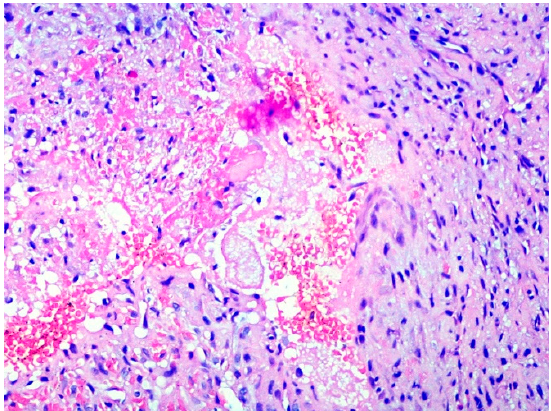
Figure 3. Fibrous connective stroma containing abundant vascular tissue; vascular lacunae appeared filled by fragmented and coagulated red blood cells, sometimes with a ghost-like appearance, as a result of the diode laser photocoagulation.